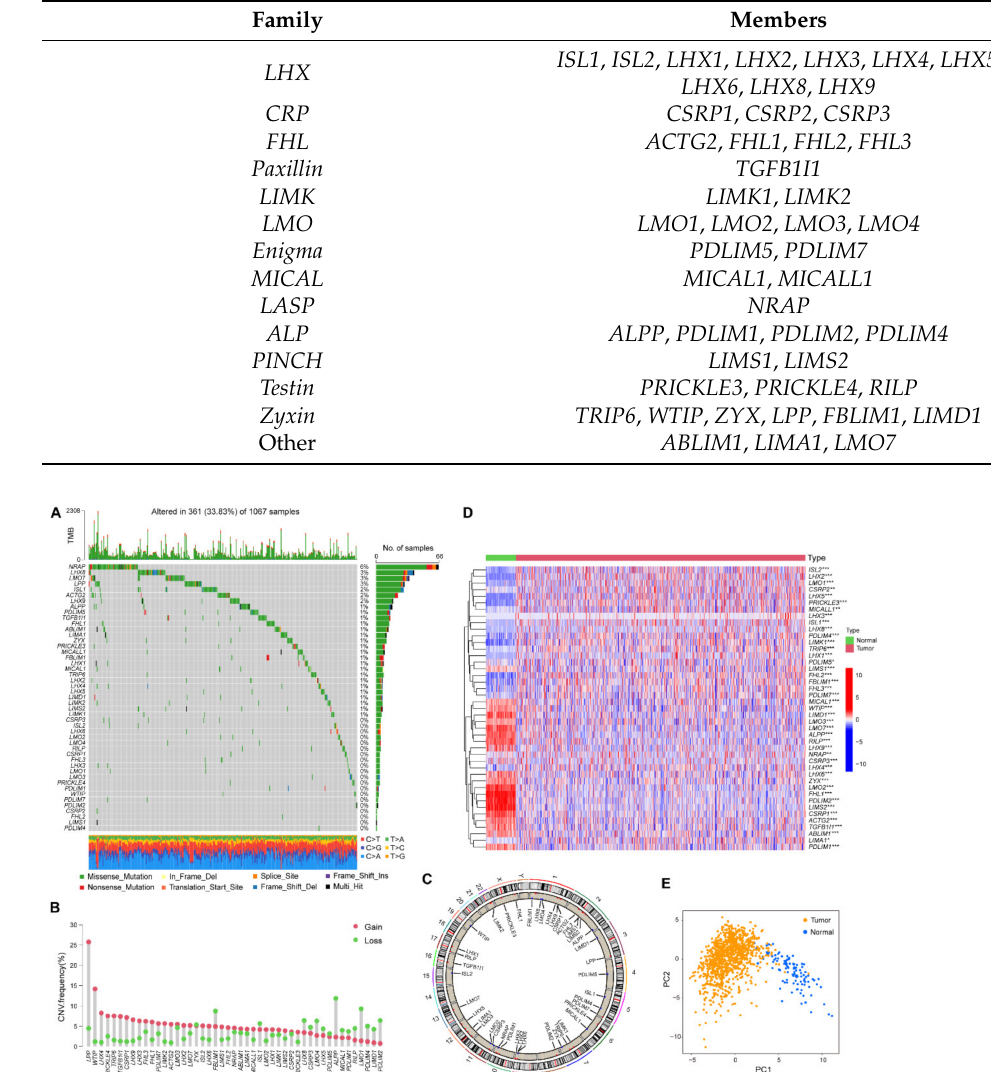
Table 1. Members of the LIM domain family genes.